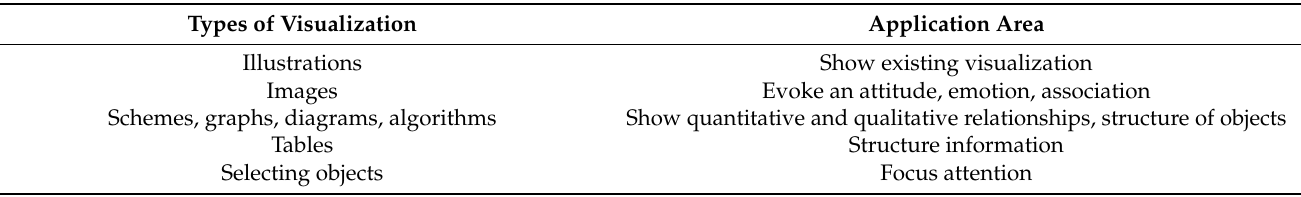
Table 1. Types of visualization and application